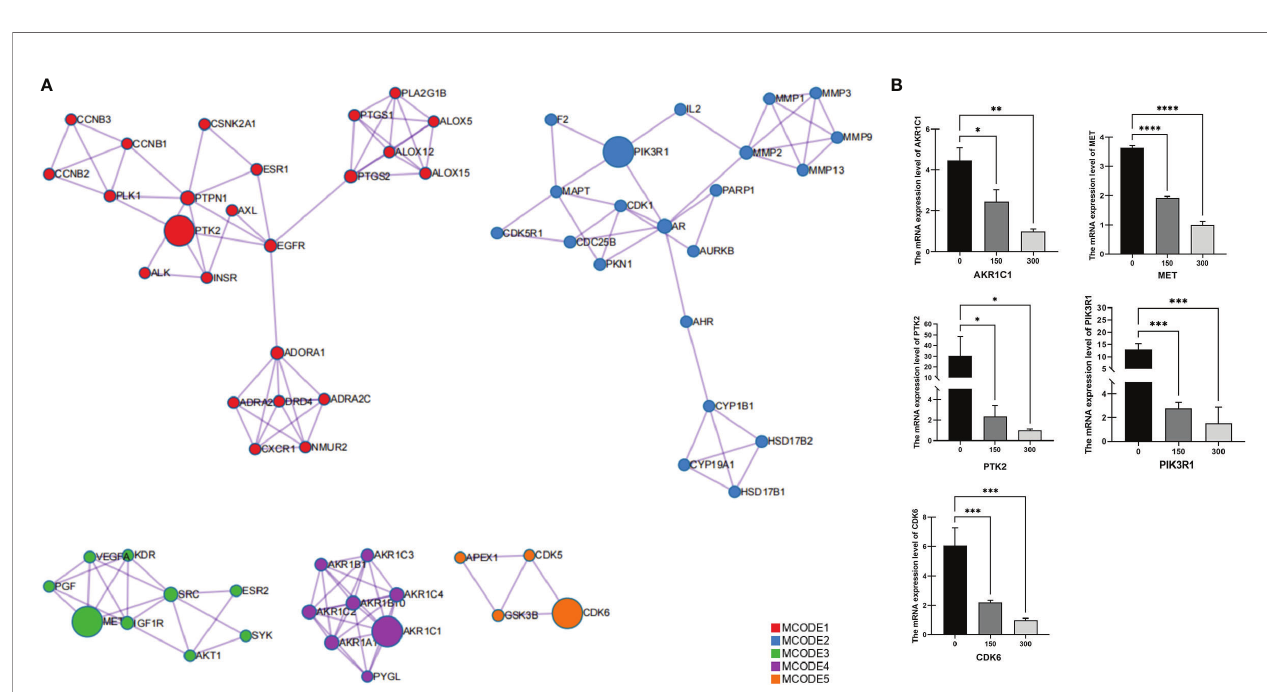
FIGURE 2 | Identi fi cation of protein – protein interaction network hub genes for potential target proteins of T. hemsleyanum . (A) Hub gene screened by MCODE. (B) Quantitative PCR analysis con fi rmed that the aqueous extract of T. hemsleyanum was involved in the gene expression regulation of hub genes AKR1C1, MET, PTK2, PIK3R1, and CDK6. *p < 0.05, **p < 0.01, ***p < 0.001, ****p < 0.0001